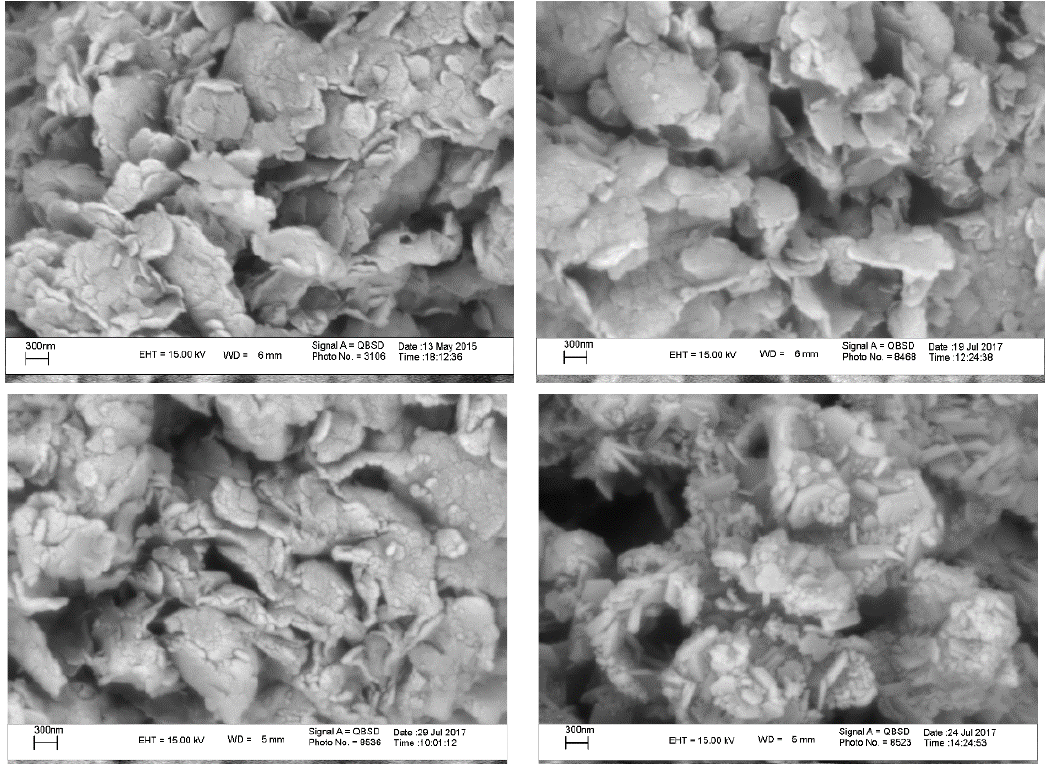
Fig. 1. Typical SEM images of parent bentonite (a) and ZnO/bentonite photocatalyst prepared using LSIE (b) and SSIE (c) and precipitation method